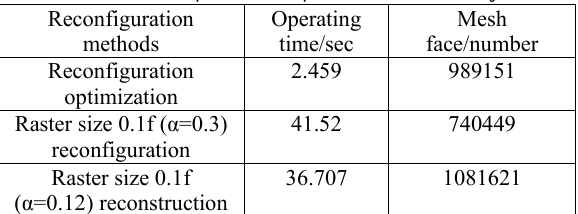
Figure 20 . Comparison of optimized results(left is α=0.12 and optimized, right is α=0.3 reconstructed Table 4 .Comparison of optimization efficiency